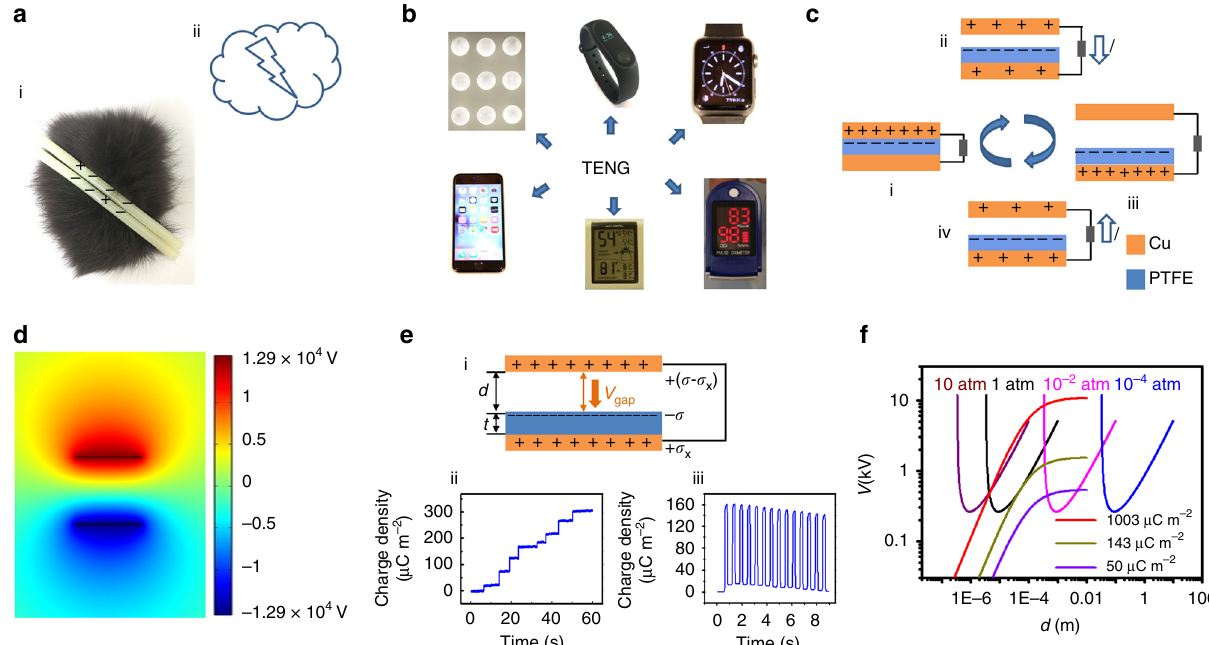
Fig. 1 Contact electri fi cation and air breakdown. a Phenomena of contact electri fi cation in nature, such as lighting and triboelectri fi cation of rubber rod and fur. b Applications of triboelectric nanogenerators (TENGs) for driving electronic devices, such as electric bulb, fi tness tracker, electric watch, health monitor, temperature-humidity meter, and cell phones. c Working mechanism of contact-separation TENG. d Finite-element simulation of the potential distribution between two triboelectric materials, copper and polytetra fl uoroethylene (PTFE) with a gap distance of 1 cm and a surface charge density of 50 µ C m − 2 using COMSOL. e Output charge density of TENG after ion air injection. Top insert shows schematic of gap voltage ( V gap ) between the metal electrode and the dielectric fi lm, which could cause the breakdown of the air; bottom-left insert records the in situ measurement of the charge fl ow from the ground to the bottom electrode of the PTFE fi lm during the step-by-step ion injection process; bottom-right insert plots the charge transfer between the two electrodes of TENG operating after the ion injection. f Air breakdown voltage at different pressures and gap voltage of TENG with different charge densities. The thickness of PTFE fi lm is 200 µ